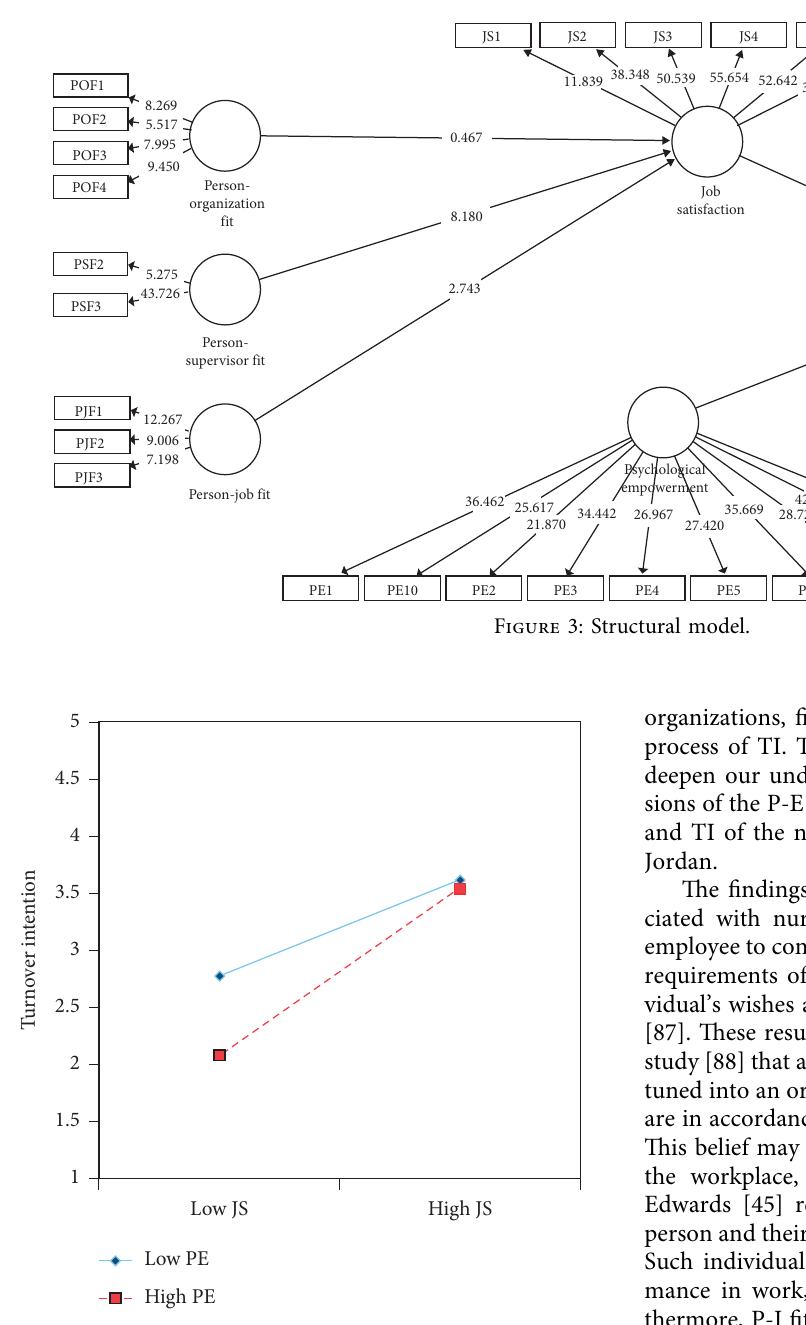
Figure 4: Interaction effect of job satisfaction and psychological empowerment on turnover